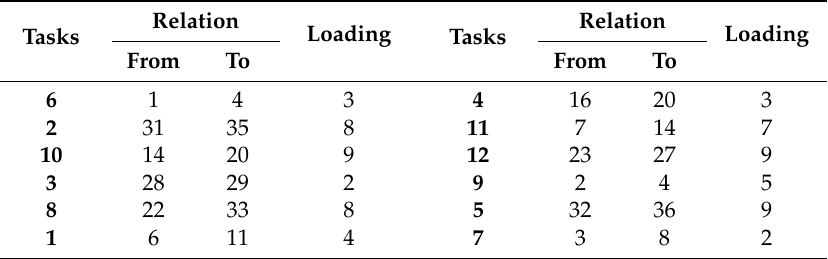
Table 6. Results of clustering.